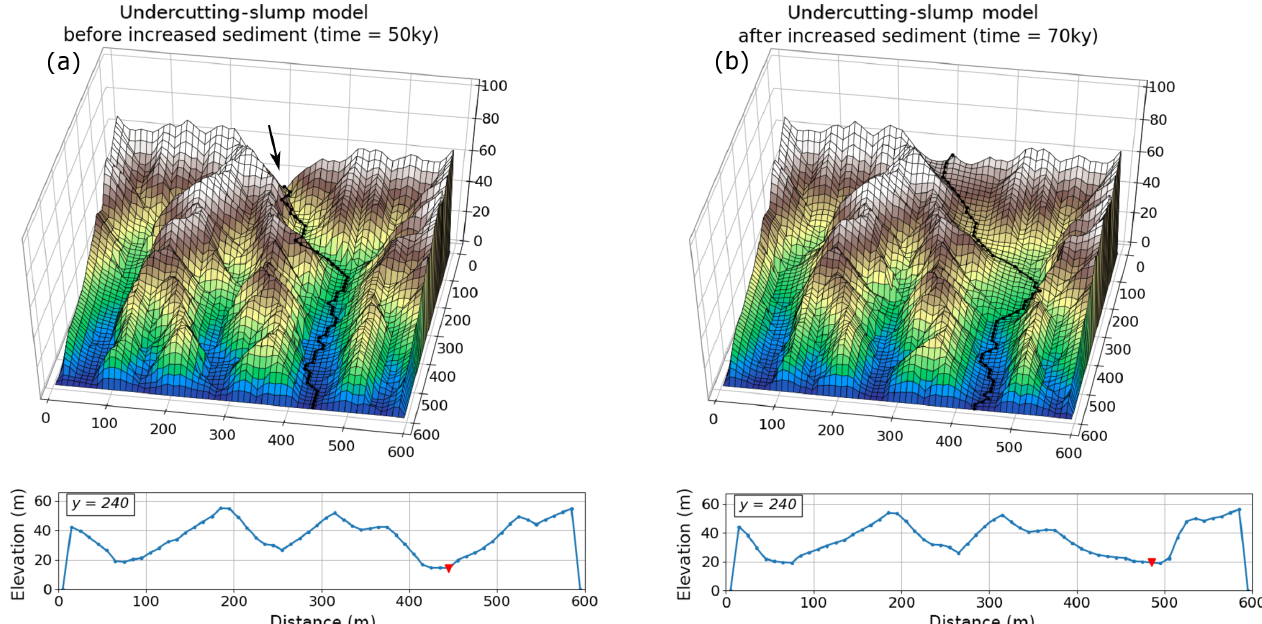
Figure 13. Model topography and cross sections at y = 420 during the period of increased sediment flux for the undercutting-slump model with α = 1 . 5 and K l /K v = 1 . 5. The black line indicates the position of the main channel on the landscape. The red triangle shows the position of the main channel in the cross section. (a) Before increased sediment flux is introduced at the input point, indicated with the arrow. (b) After 20kyr of increased sediment flux, the channel has aggraded by 5m and has eroded the valley wall by